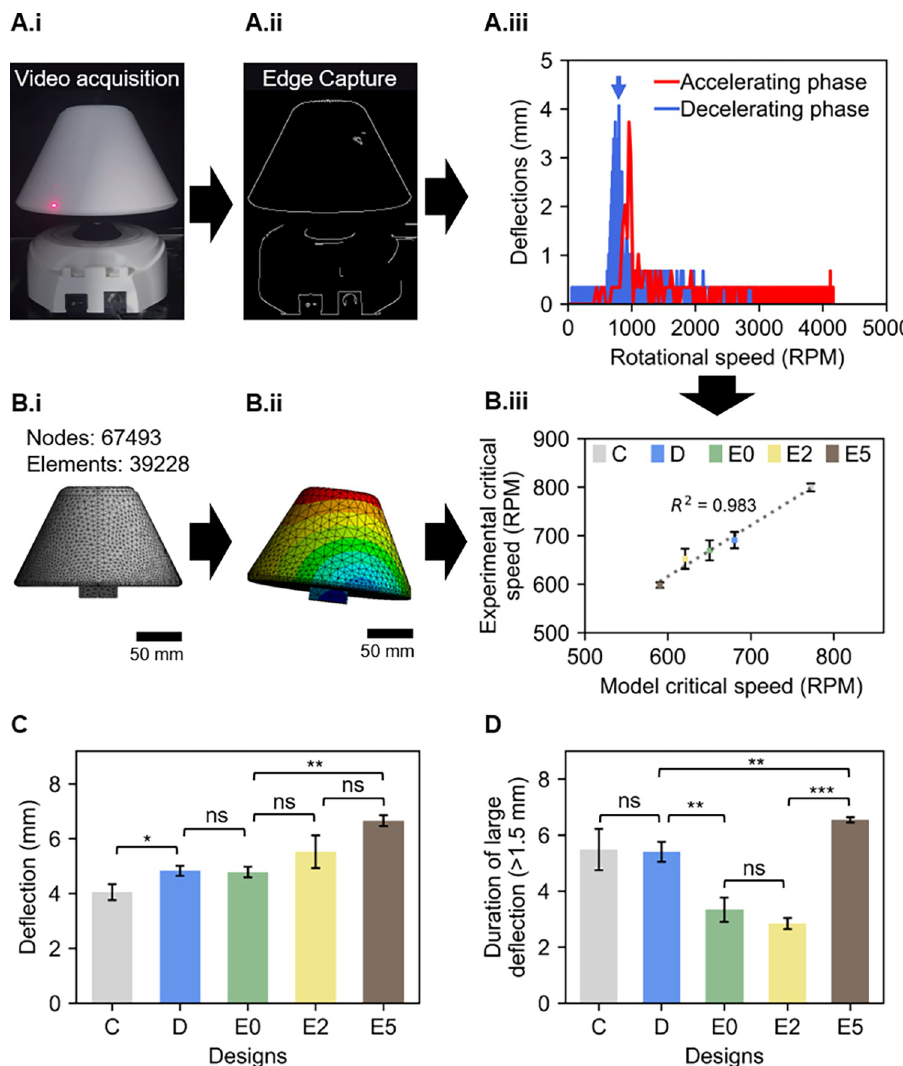
Fig 5. (A) Deflection measurement from the recorded video of conical Design C. A.i) Snapshot of one of the video recordings of Design C A.ii) Edge capturing from one of Design C videos using Canny, an edge detection operator in Python OpenCV module. Further details about the deflection measurements are available in (S1 Fig in S1 File) A.iii) Measured deflection of both acceleration and decelerating phase from the recorded video using python OpenCV module for Design C. All recordings are available from (S2 Fig in S1 File) (B) Critical speed measurement in Ansys workbench B.i) Meshing of Design C (Nodes: 6749, Elements: 39228) C B.ii) Mode shape during natural frequency B. iii) Simulated (model) vs experimental critical speed of each conical shape design showing a good agreement between them with low percentage difference (1–5%) (C) Measured deflection of each conical shape design showing all designs experiencing deflection from 4 to 7 mm (D) Duration of deflection higher than 1.5 mm was decreasing the lowering of critical speed except design E5 which experienced higher deflection for longer